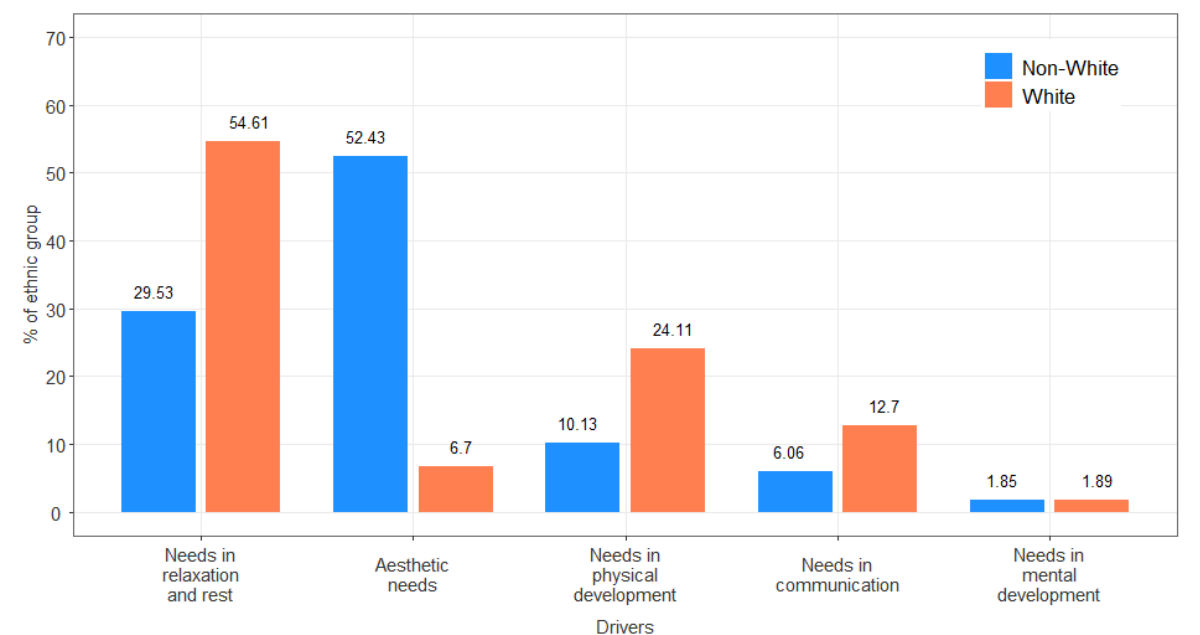
Figure 5. Percentage distribution of the main drivers for forest recreation activities among the respondents from the different ethnic groups.